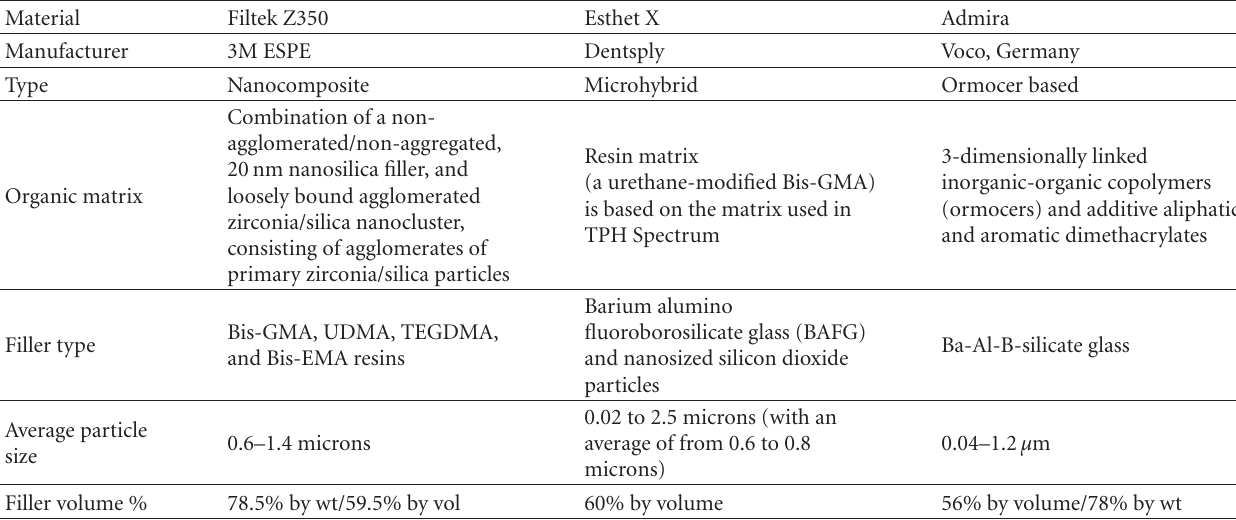
Table 1: Physical characteristics of experimental